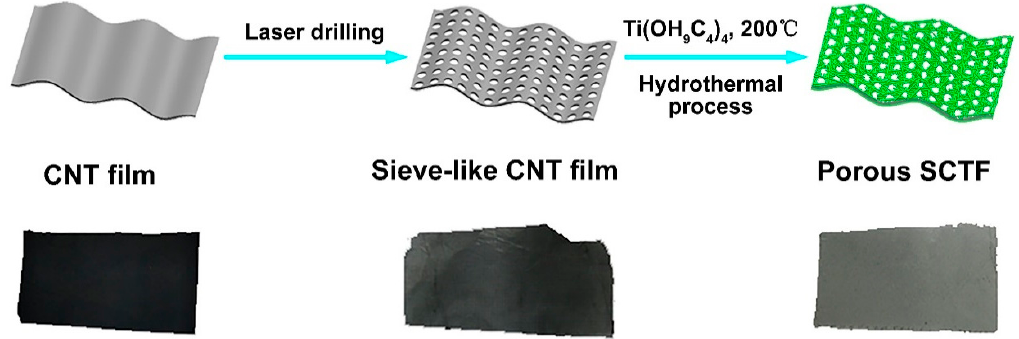
Figure 1. The schematic procedure of fabricating sieve-like carbon nanotube (CNT)/TiO2 nanowire film (SCTF) and the corresponding films obtained at each step.